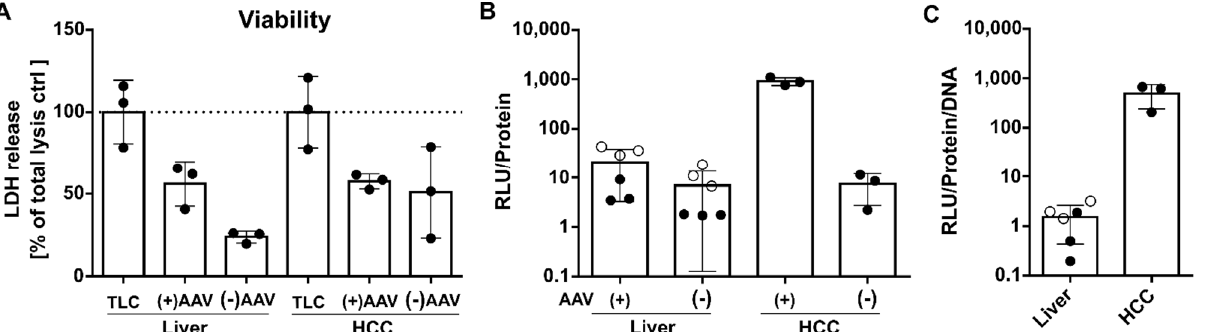
Figure 8. AAV2 expression in HCC compared to liver tissue in a human PCLS model. In vitro cultured PCLS processed from human liver parenchyma (P-PCLS) and HCC tissue (T-PCLS) were transduced with 4 × 10 10 sc.AAV2. SFFV.Fluc vector particles per 2 PCLS (Ø 8 mm, 200 to 300 µm strength) per well; 24 h p.t., PCLS were harvested. ( A ) Viability analysis of HCC patient-derived PCLS by LDH assay. ODs are normalized to untransduced total lysis control (TLC), which was treated as “total death” control with Triton-X 100. Data are shown in the linear scale as the LDH release in % with mean and SD. ( B ) Luciferase activity is depicted as relative light units (RLU) normalized to protein content, quantified by Bradford assay. Data are shown in log 10 -scale as the RLU per protein with mean and SD. ( C ) Transgene expression index of AAV-treated PCLS, defined as the ratio of luciferase activity to vector genome content. Data are shown in log 10 -scale as RLU per protein per DNA with mean and SD. Statistics: N/A for the number of independent experiments. ( A ) N = 1 HCC patient P-PCLS (liver), and N = 1 matched T-PCLS (HCC); ( A , B ). N = 1 non-HCC patient P-PCLS (liver, clear circles); N = 1 HCC patient P-PCLS (dark circles); N = 1 matched T-PCLS (dark circles). ( A – C ) are technical replicates ( n = 3), with the mean values of 2 PCLS samples/well.